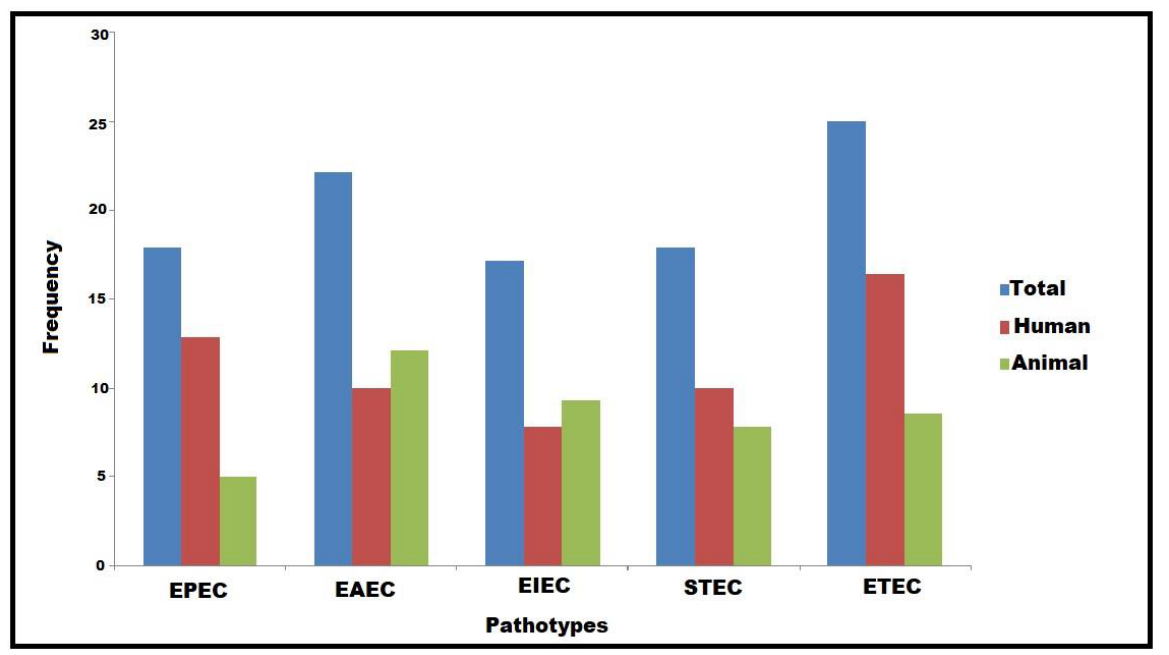
Figure 1. Occurrence and distribution of DEC pathotypes among human and animal hosts. EAEC: